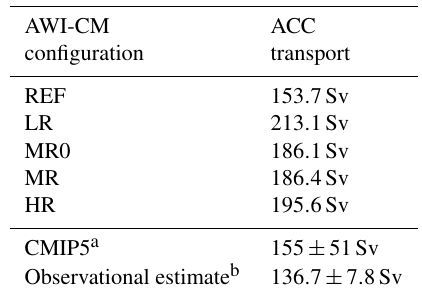
Table 3. Transport of the ACC at Drake Passage [1Sv